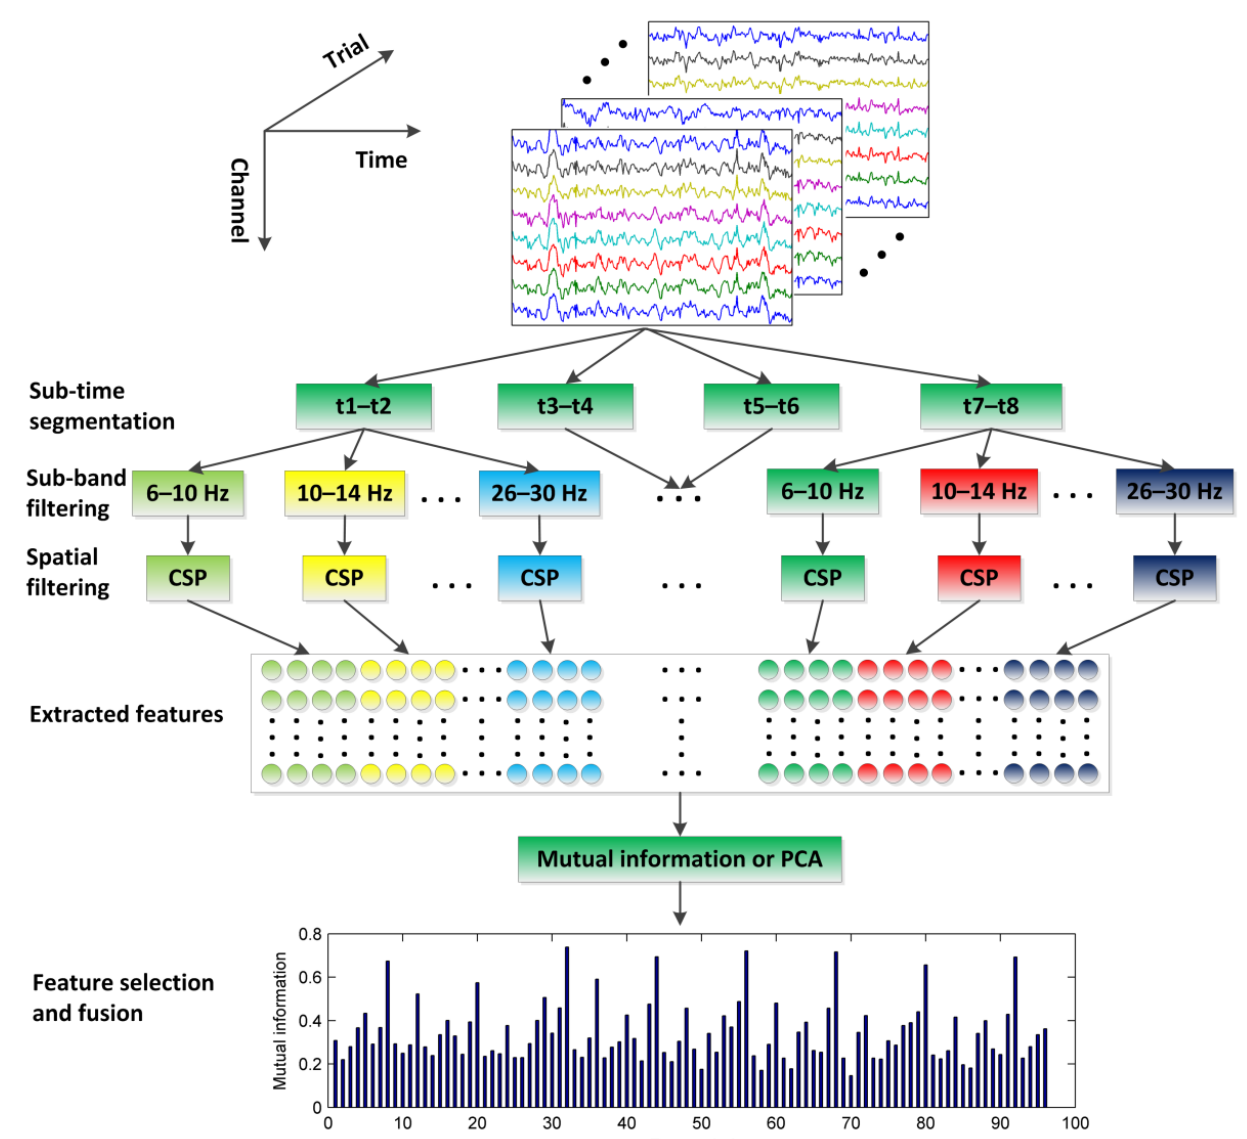
Figure 1. Illustration of the CiSSA-CSP method for motor-imagery classification.